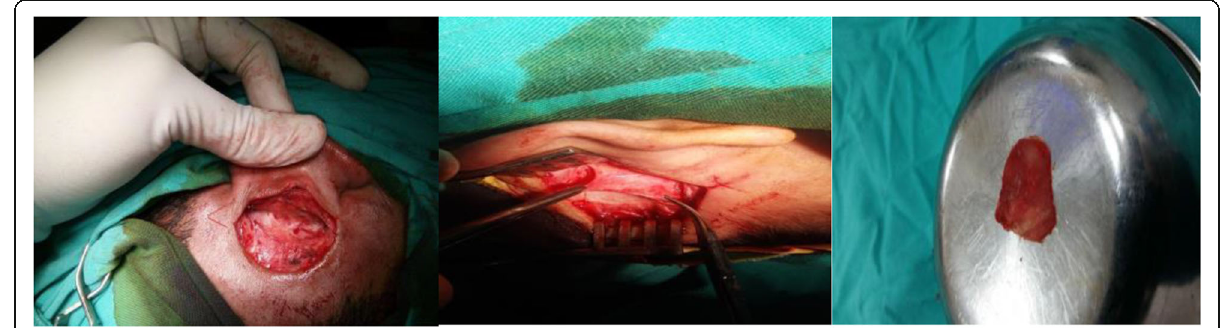
Fig. 1 Postauricular incision, dissection of periosteum graft over mastoid wall, and periosteum graft was